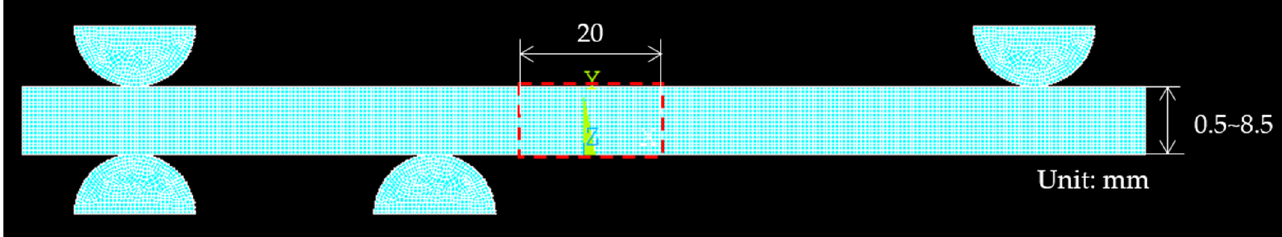
Figure 6. Analysis region for experiment and FEM analysis.